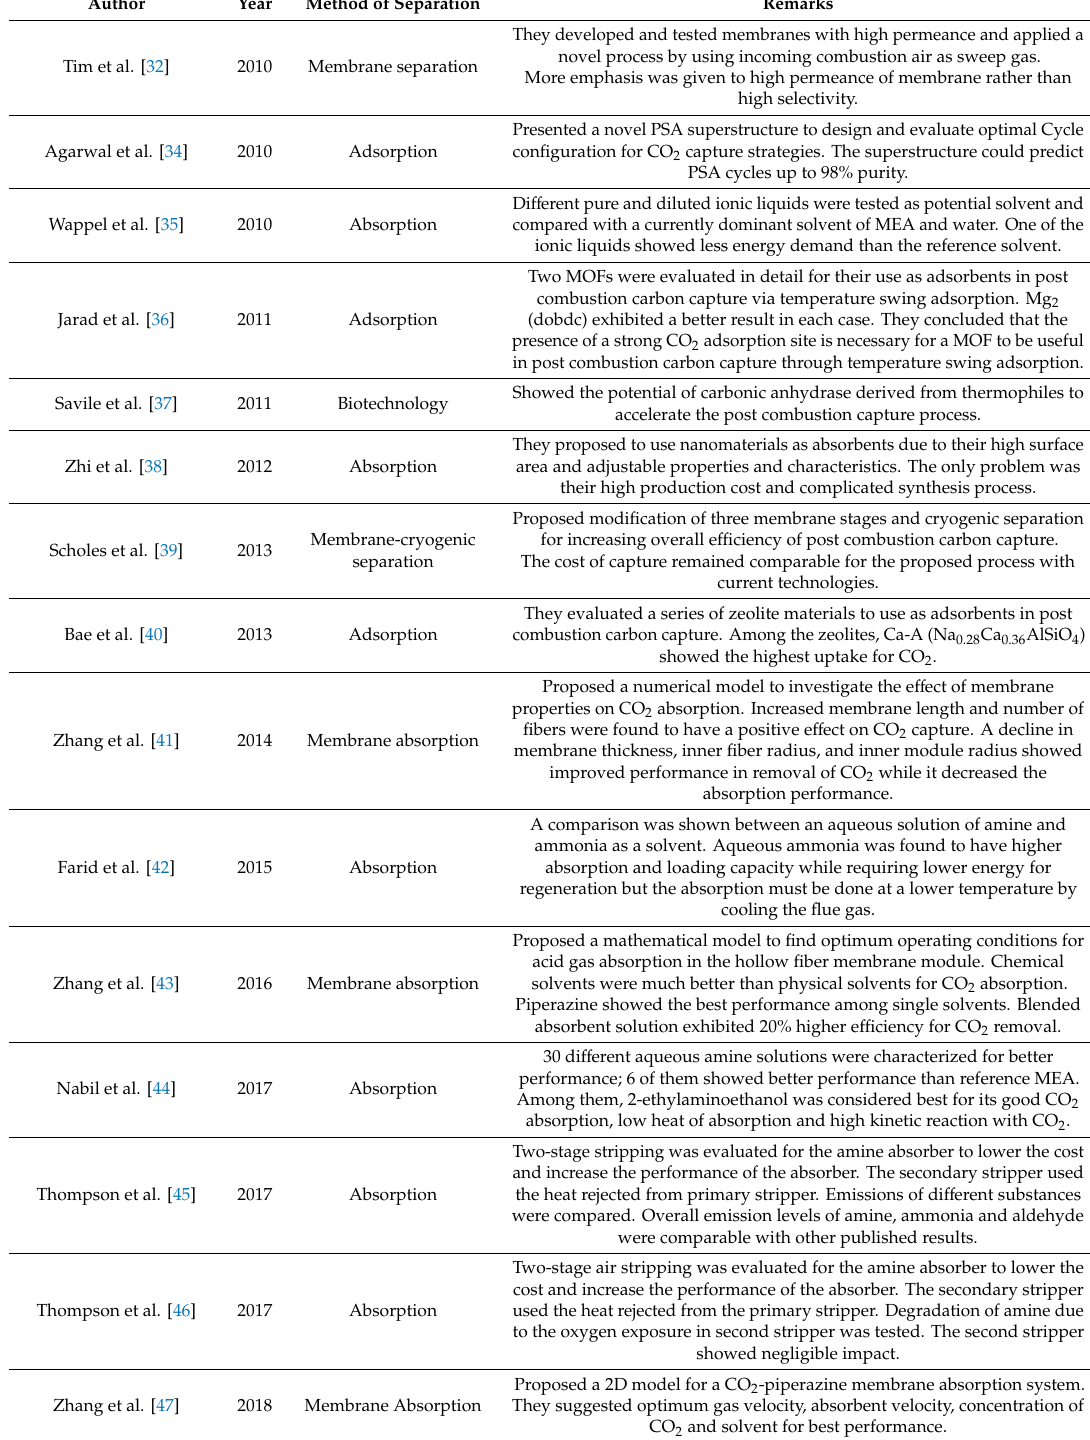
Table 3. Some of the important studies on post combustion carbon